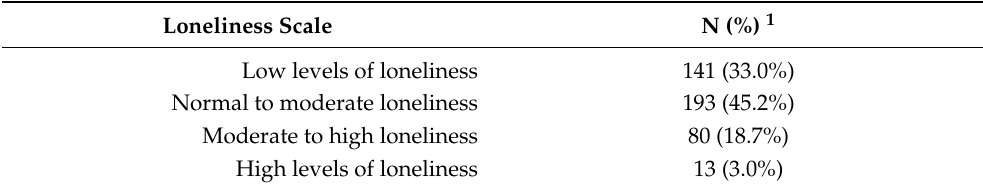
Table 4. Results for the ULS-8 short form